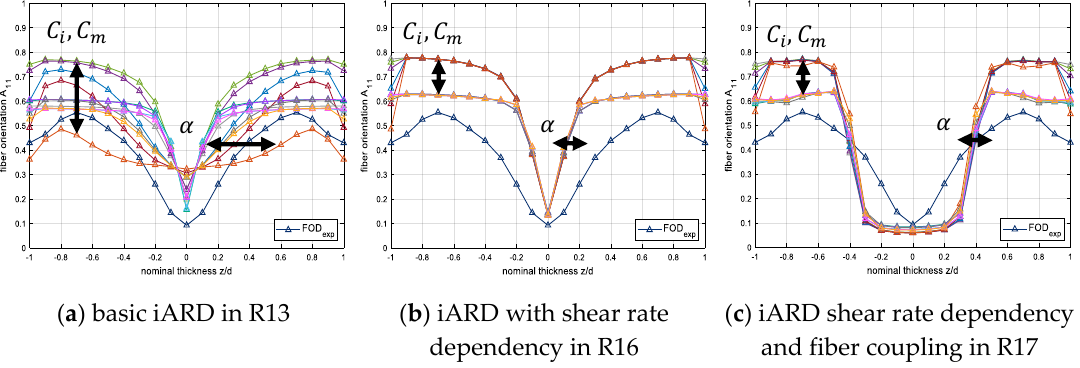
Figure 15. Influence of fiber orientation model parameters on different software versions.